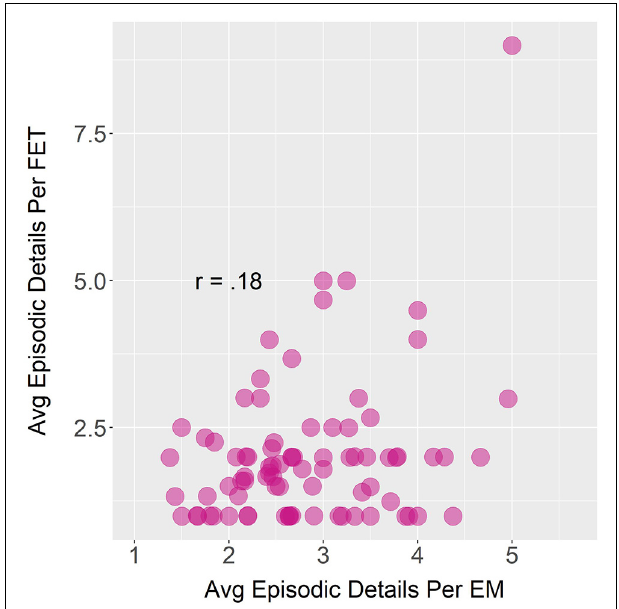
FIGURE 6 | Bivariate Spearman correlation between average (avg) past episodic details and future episodic details generated in sound files with episodic memories (EM) and future episodic thoughts (FET), respectively.